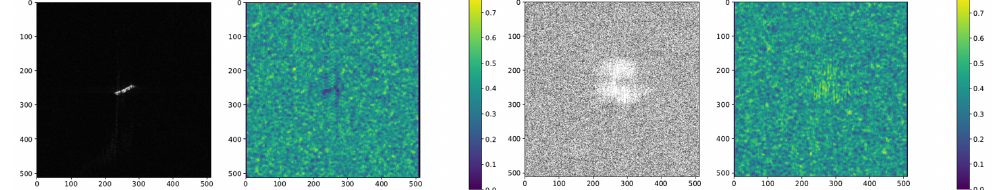
Figure 6. Example of IE calculated for ship target ( left ) and ambiguity ( right ) for a CSK